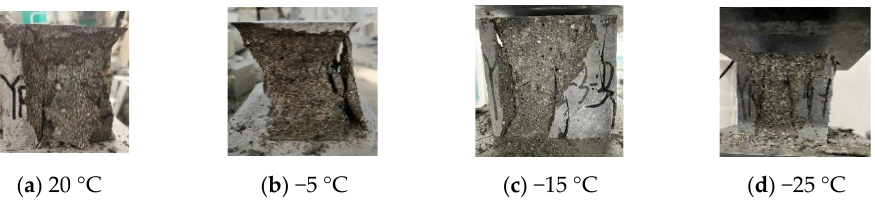
Figure 3. Compression failure modes of CFRPC3 cubic specimens after different exposure temperatures.